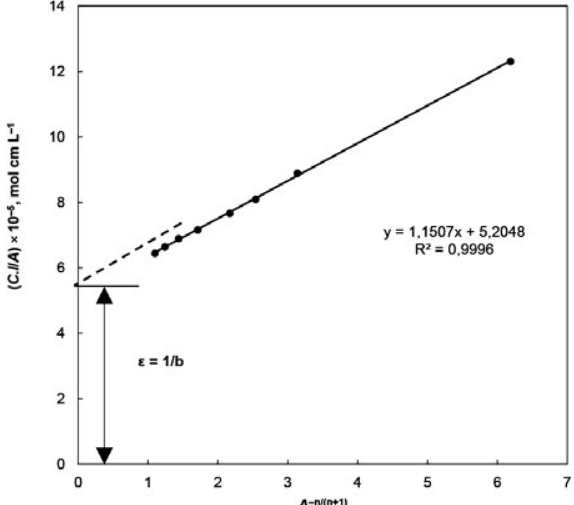
= 2.0 × 10 –4 M; 3,5-DNC